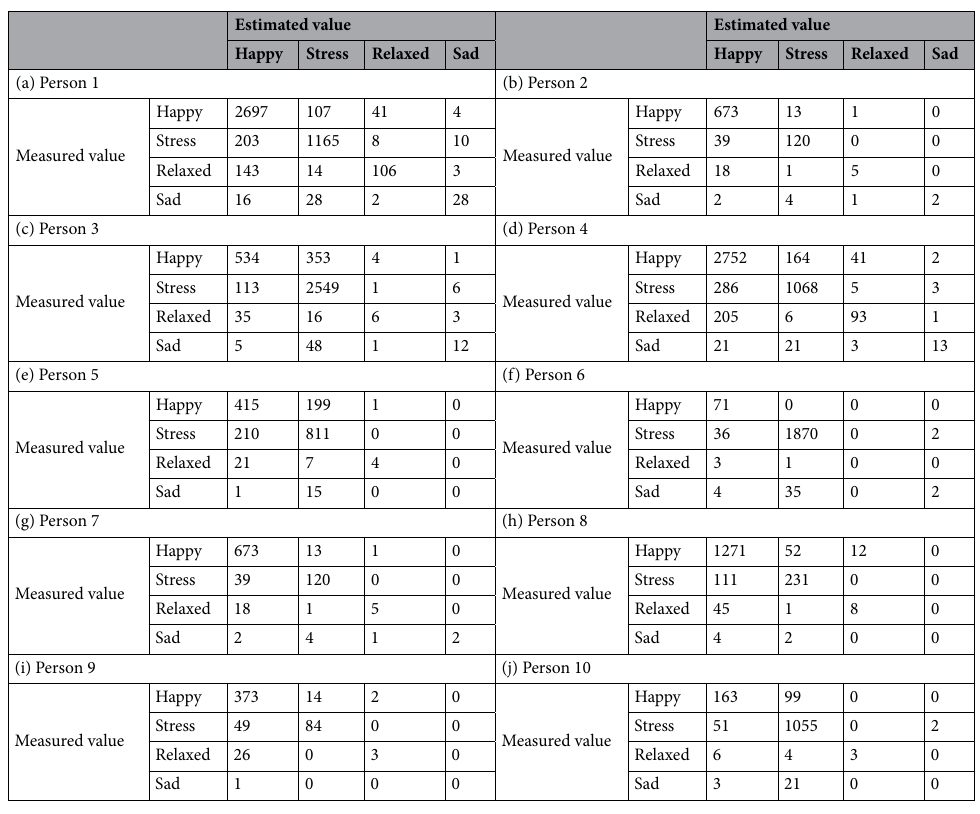
Table 7. Confusion